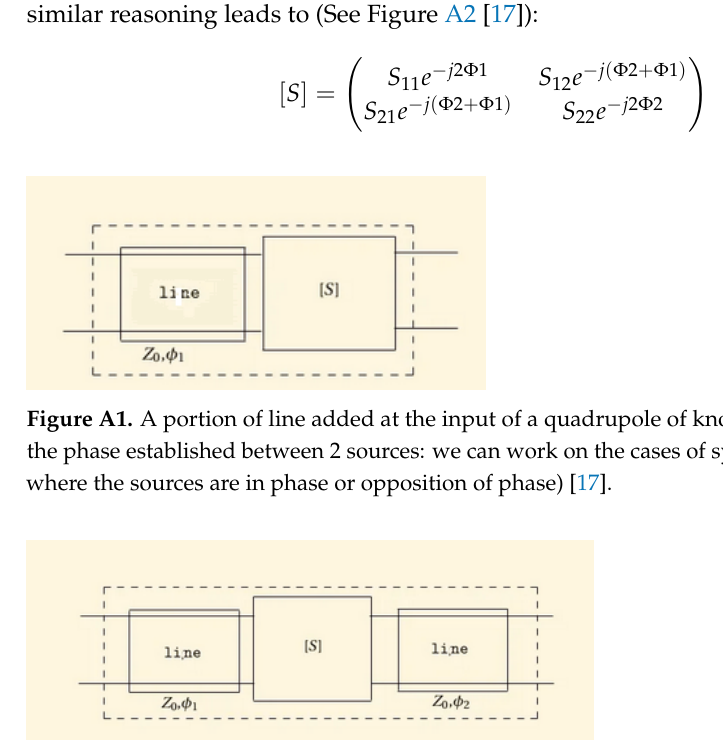
Figure A2. Line traces added to the input and output of a quadrupole of known matrix [S]